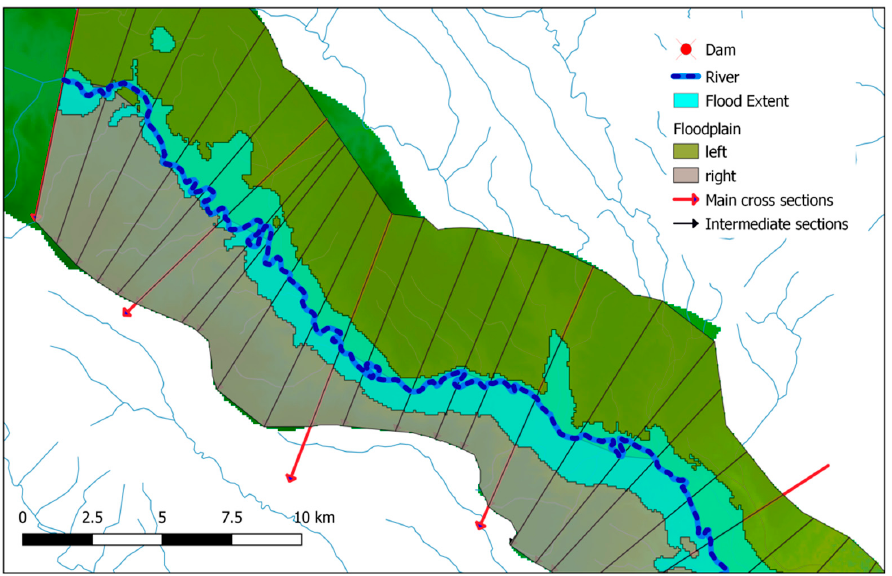
Figure 3. Example of the flood extent maps for an area of the valley downstream from the San Giuliano dam.